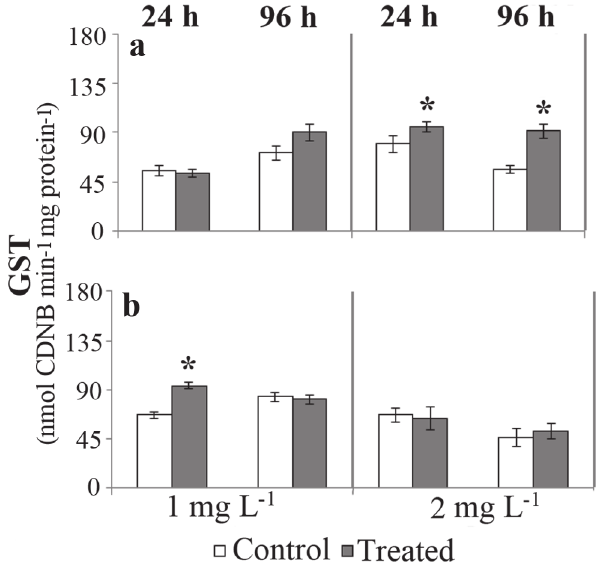
Fig. 2. Activity of glutathione S-transferase (GST) in gills ( a ) and liver ( b ) of Prochilodus lineatus exposed to 1 or 2 mg L - 1 lyophilized Microcystis aeruginosa (treated) or only water (control), for 24 and 96 h. Values are presented as mean ± SEM (n = 8). Asterisks indicate significant differences when compared to respective control (p <